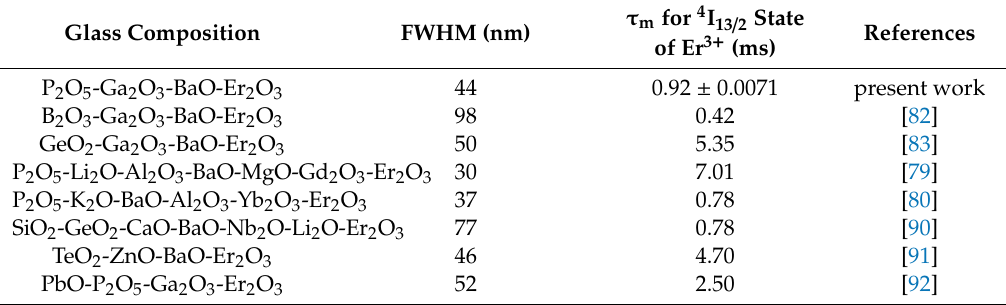
Table 5. Comparison of parameters FWHM for band at 1.5 µ m (Er 3 + ), luminescence lifetime for 4 I 13 / 2 state (Er 3 + ) of inorganic